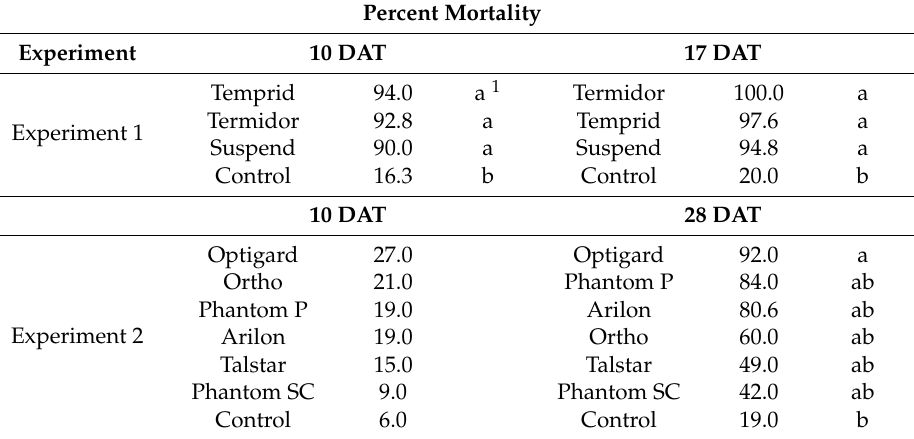
Table 3. Mean percent Nylanderia fulva mortality at 10 and 17 days after treatment (DAT) (Experiment 1) or 28 DAT (Experiment 2) when control mortality approached 20% in a bioassay requiring ants to cross a painted wood panel treated with insecticide or water (control). Insecticides were tested in two groups (Experiment 1 and Experiment 2) (n = 5 replicates for each insecticide, except for n = 4 replicates in Experiment 1).